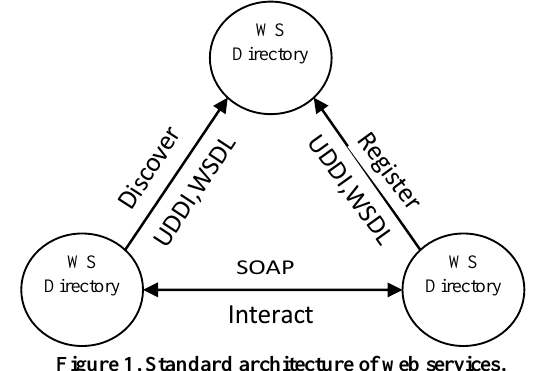
Figure 1. Standard architecture of web services.